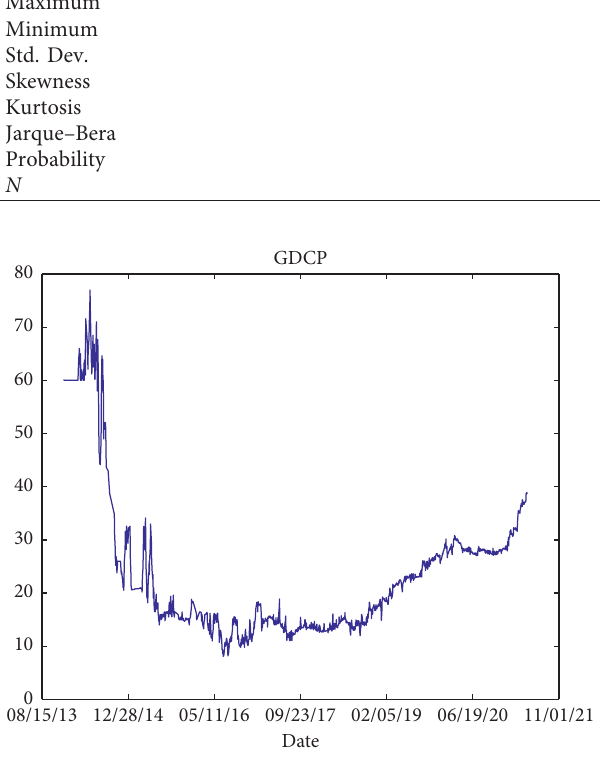
Figure 1: Evolution pattern of Guangdong carbon emission price (GDCP).